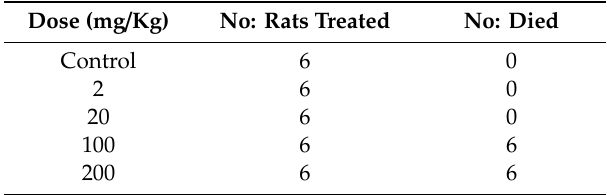
Table A1. Mortality data of the male rats in the determination of LD 50